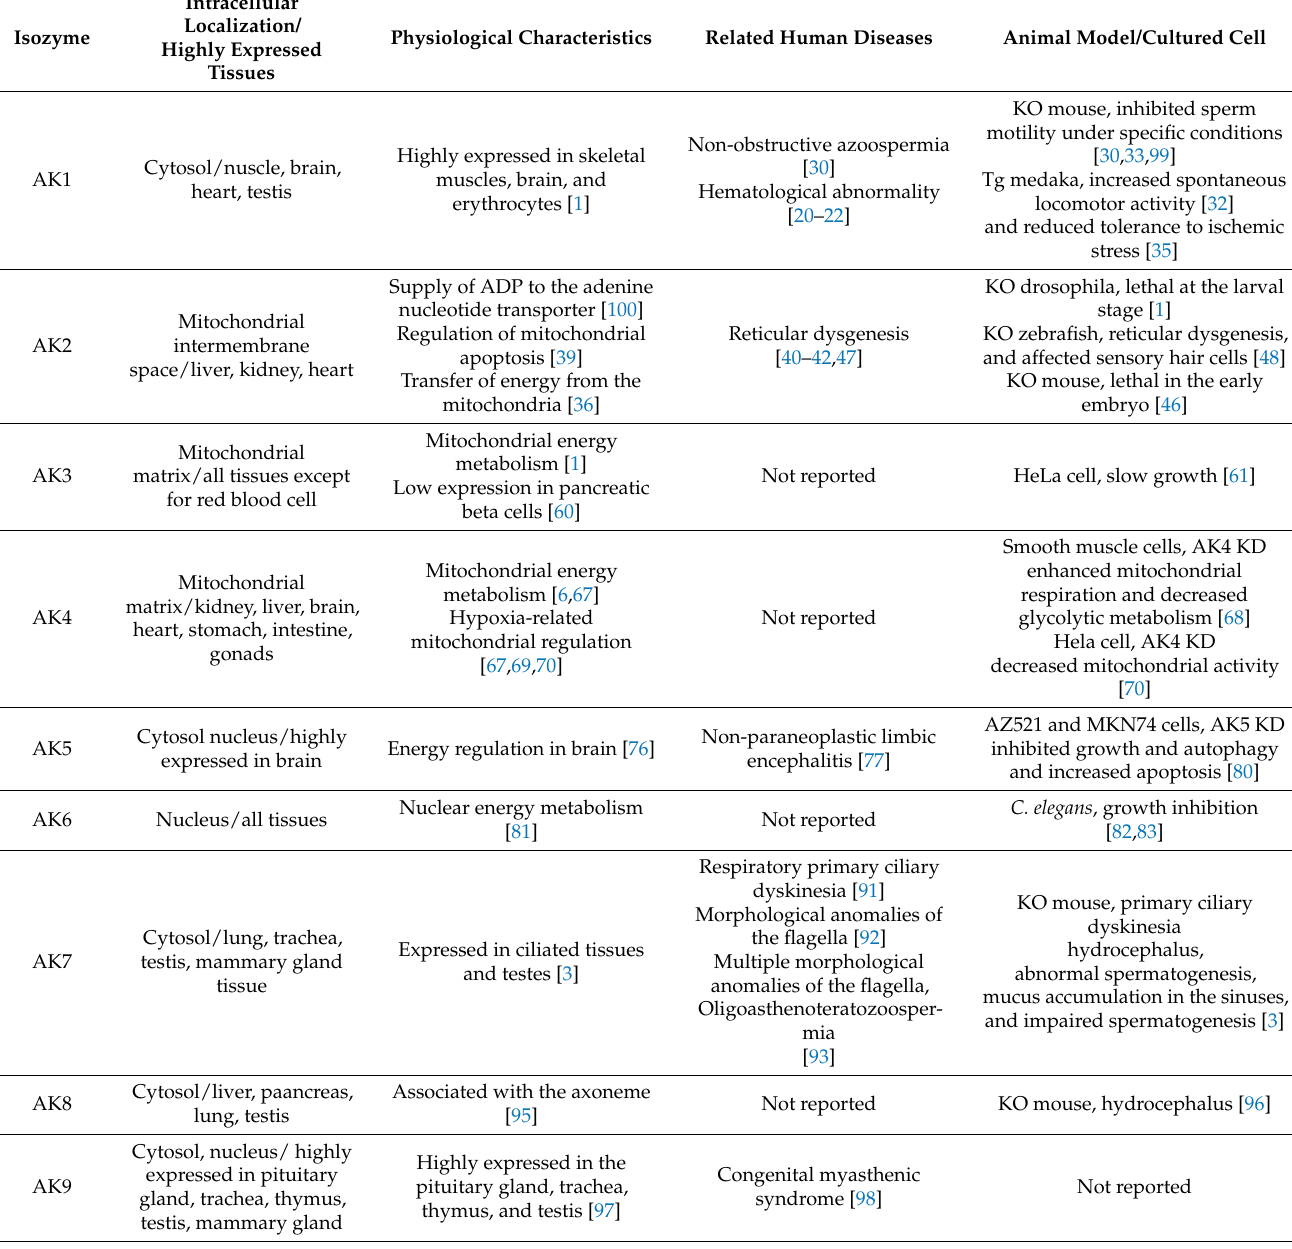
Table 1. Phenotypes of associated diseases and expression changes in each AK